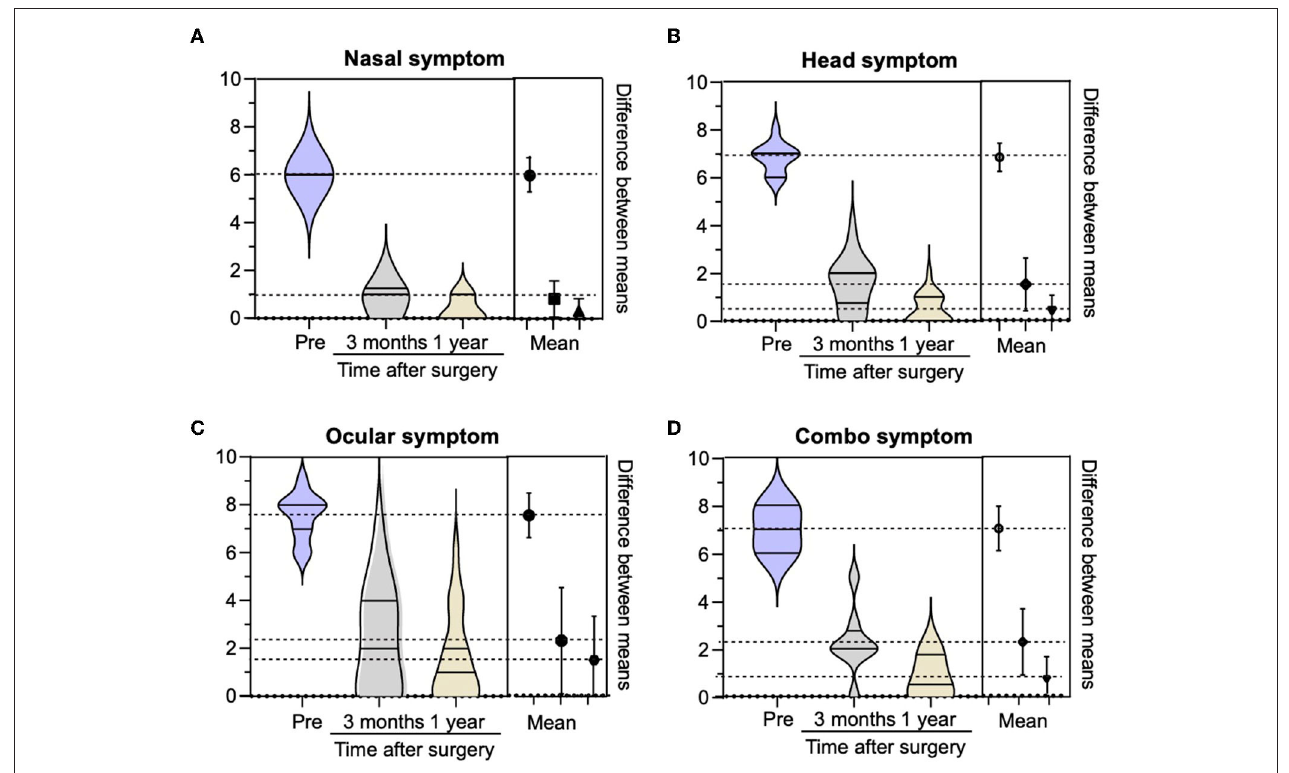
FIGURE 5 | Comparison of visual analog scores (VAS) of each symptom group preoperation, 3 months after the operation, and 1 year after the